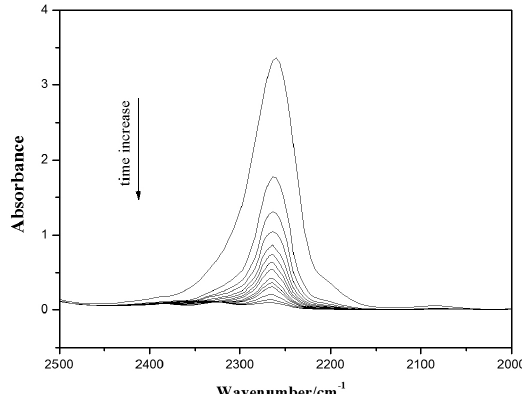
Figure 1. Changes of the FTIR spectra for the -NCO group during the curing